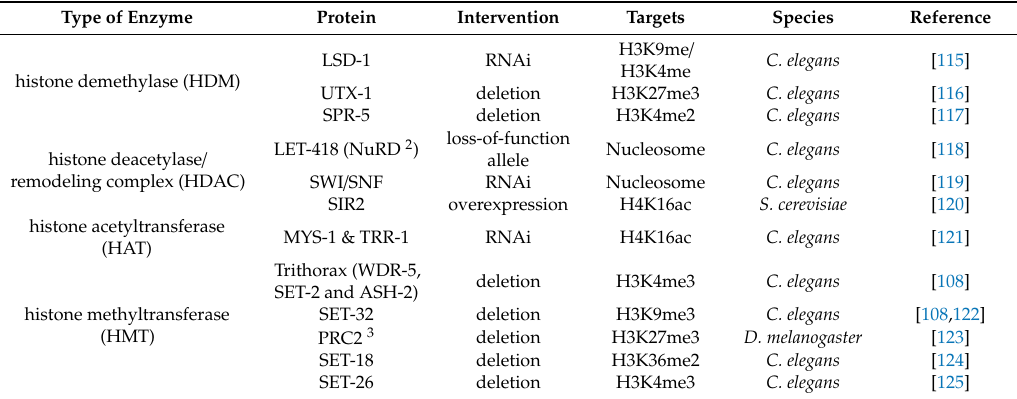
Table 2. Modifications in chromatin proteins associated with longevity.